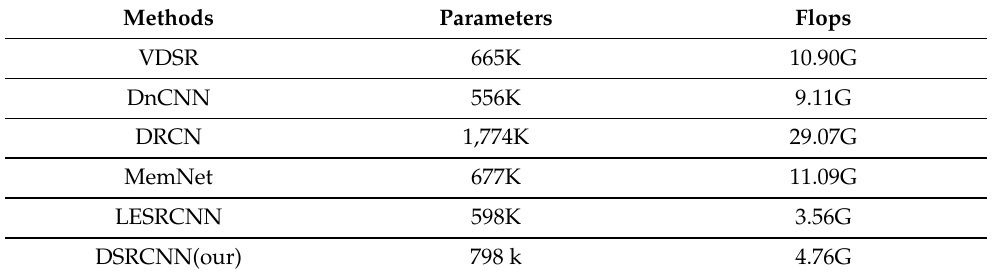
Table 6. Complexity of six networks for